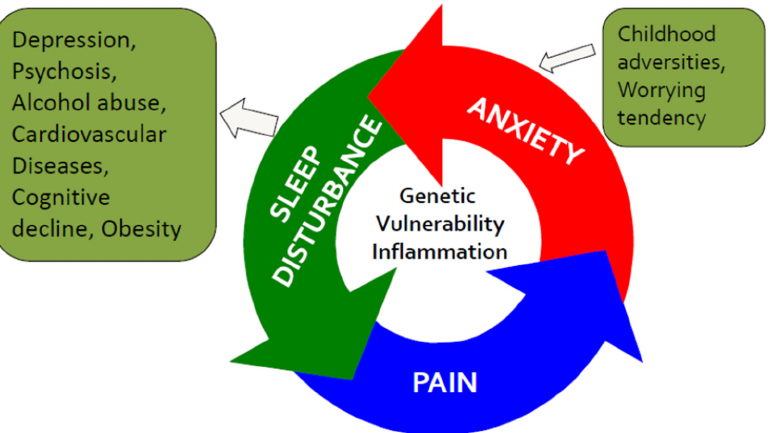
Figure 1. The vicious circle of the association between pain, anxiety, and disturbed sleep. Early-life exposure to stressful events is a vulnerability factor for anxiety, sleep disturbances, and pain in